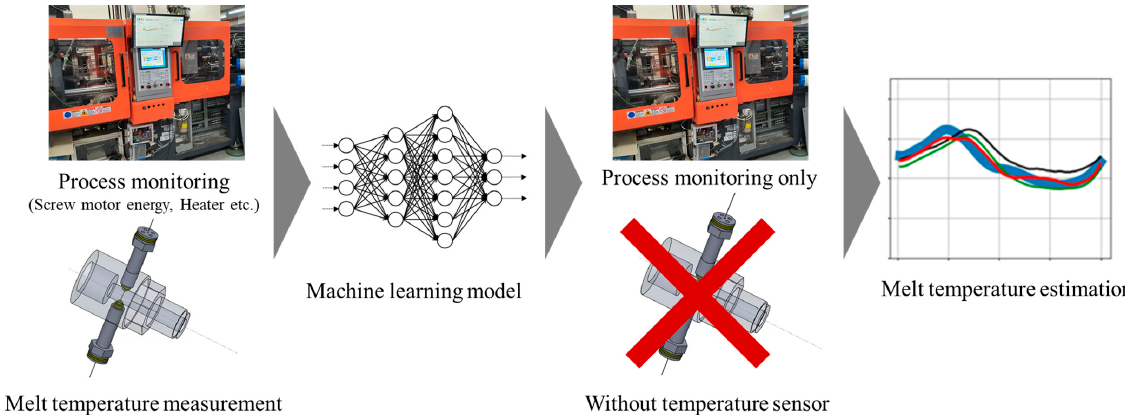
Figure 2. Schematic illustration of the proposed methodology.